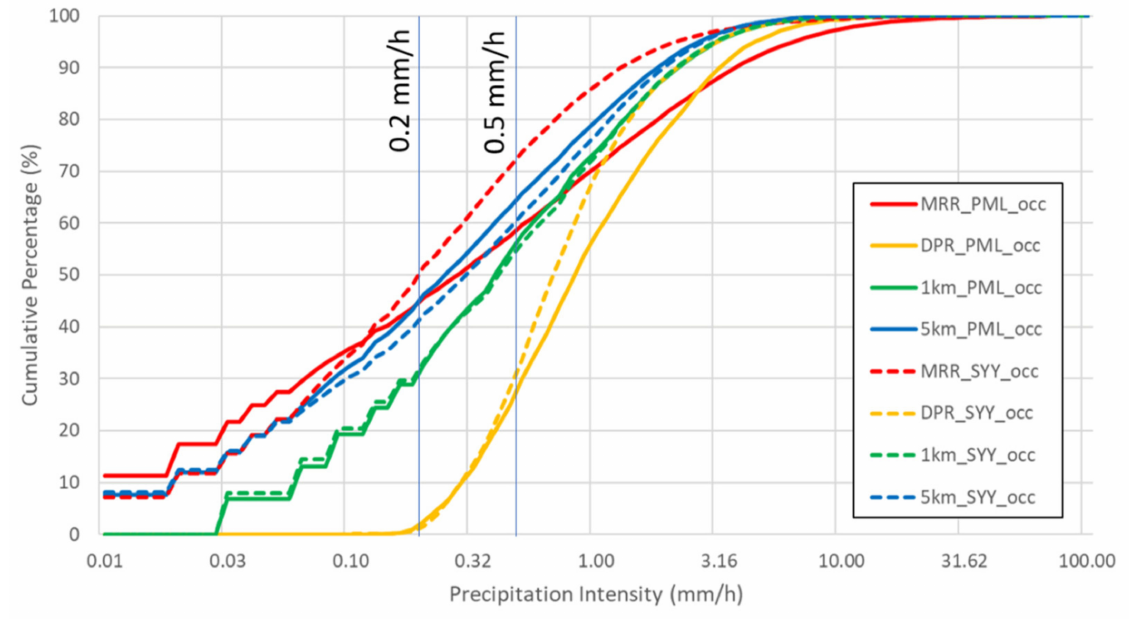
Figure 2. Occurrence of precipitation as observed at the PML (continuous lines) and SYY (dashed lines) locations for the MRR (red), DPR (yellow), 1-km radar (green) and 5-km radar